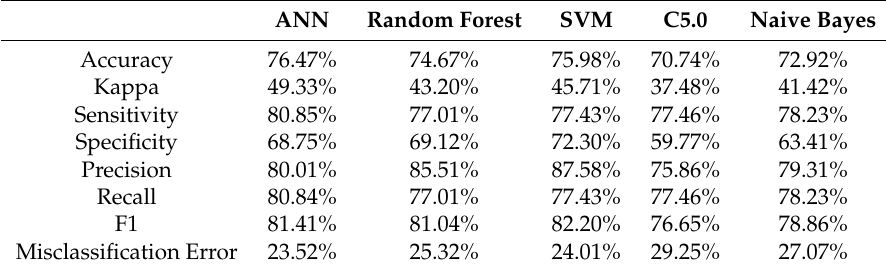
Table 2. Evaluation criteria for Diabetics prediction after implementing Genetic algorithm.